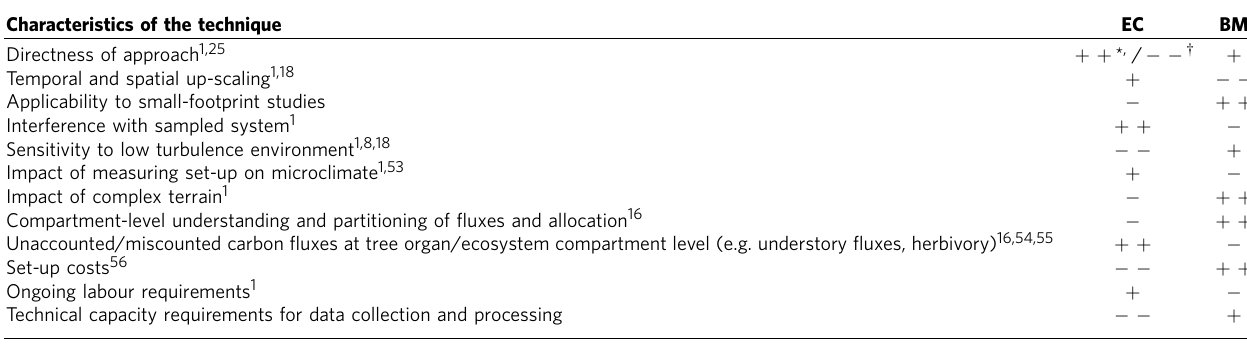
Very positive ( þ þ ), positive ( þ ), negative ( (cid:2) ) or very negative ( (cid:2) (cid:2) ) characteristics of the eddy-covariance (EC) and biometric (BM) methods used for the determination of net ecosystem production (NEP), ecosystem respiration (Reco) and gross primary production (GPP) of forest ecosystems. *NEP. w Reco and GPP.